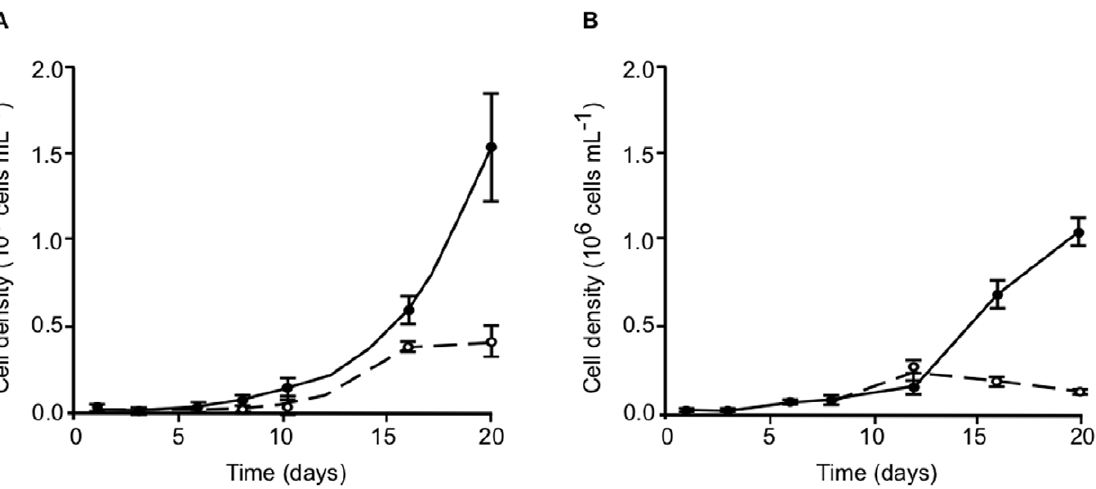
Figure 5. Growth of Symbiodinium cells under osmotic stress. ( A ) Symbiodinium type B17 and ( B ) type A1 cultures were inoculated with 1 6 10 4 cells mL 2 1 . After 6 days growing under control conditions (solid lines), half of the culture was transferred and stressed by adding 9% PEG (broken lines). Means 6 SD from three independent experiments are shown.